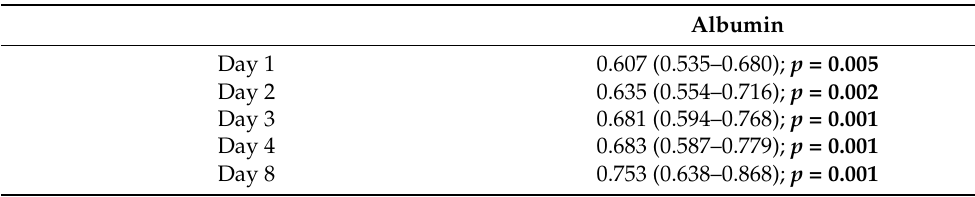
Table 4. Prognostic performance of the albumin level on days 1, 2, 3, 4, and 8, analyzed as the area under the curve (95% CI).